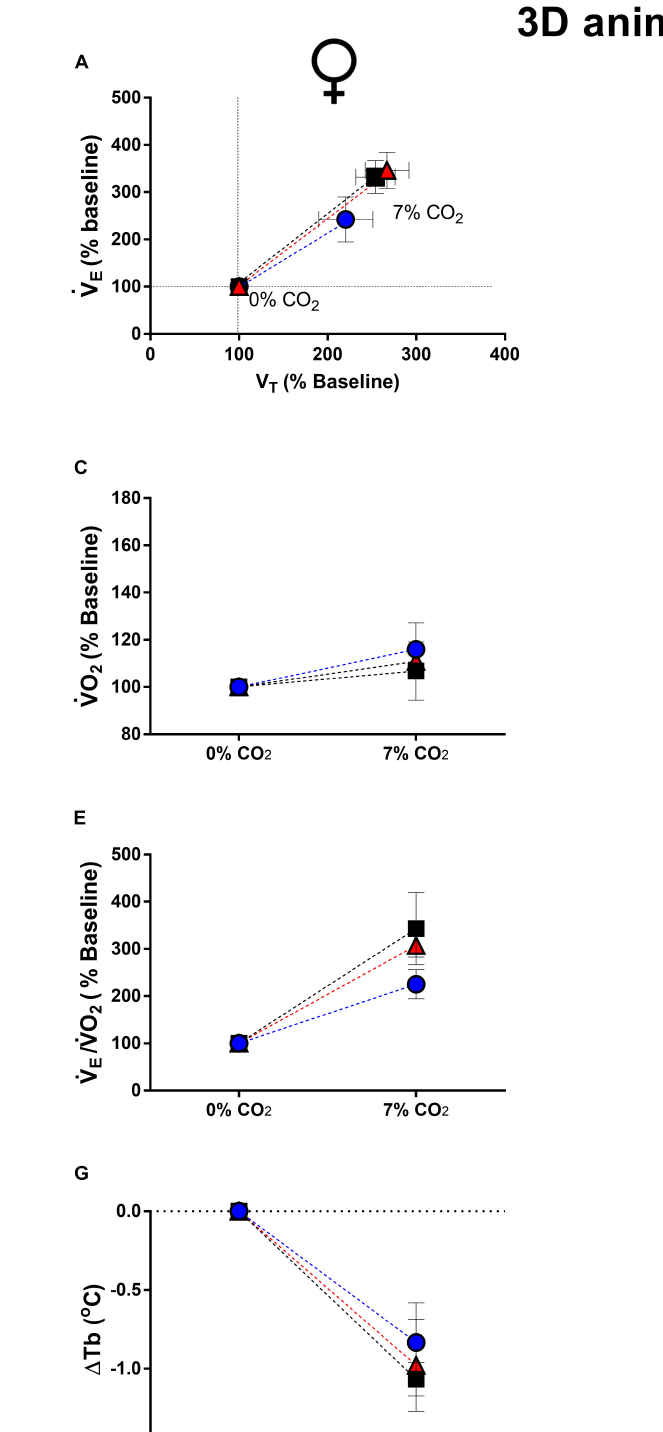
Frontiers in Physiology |